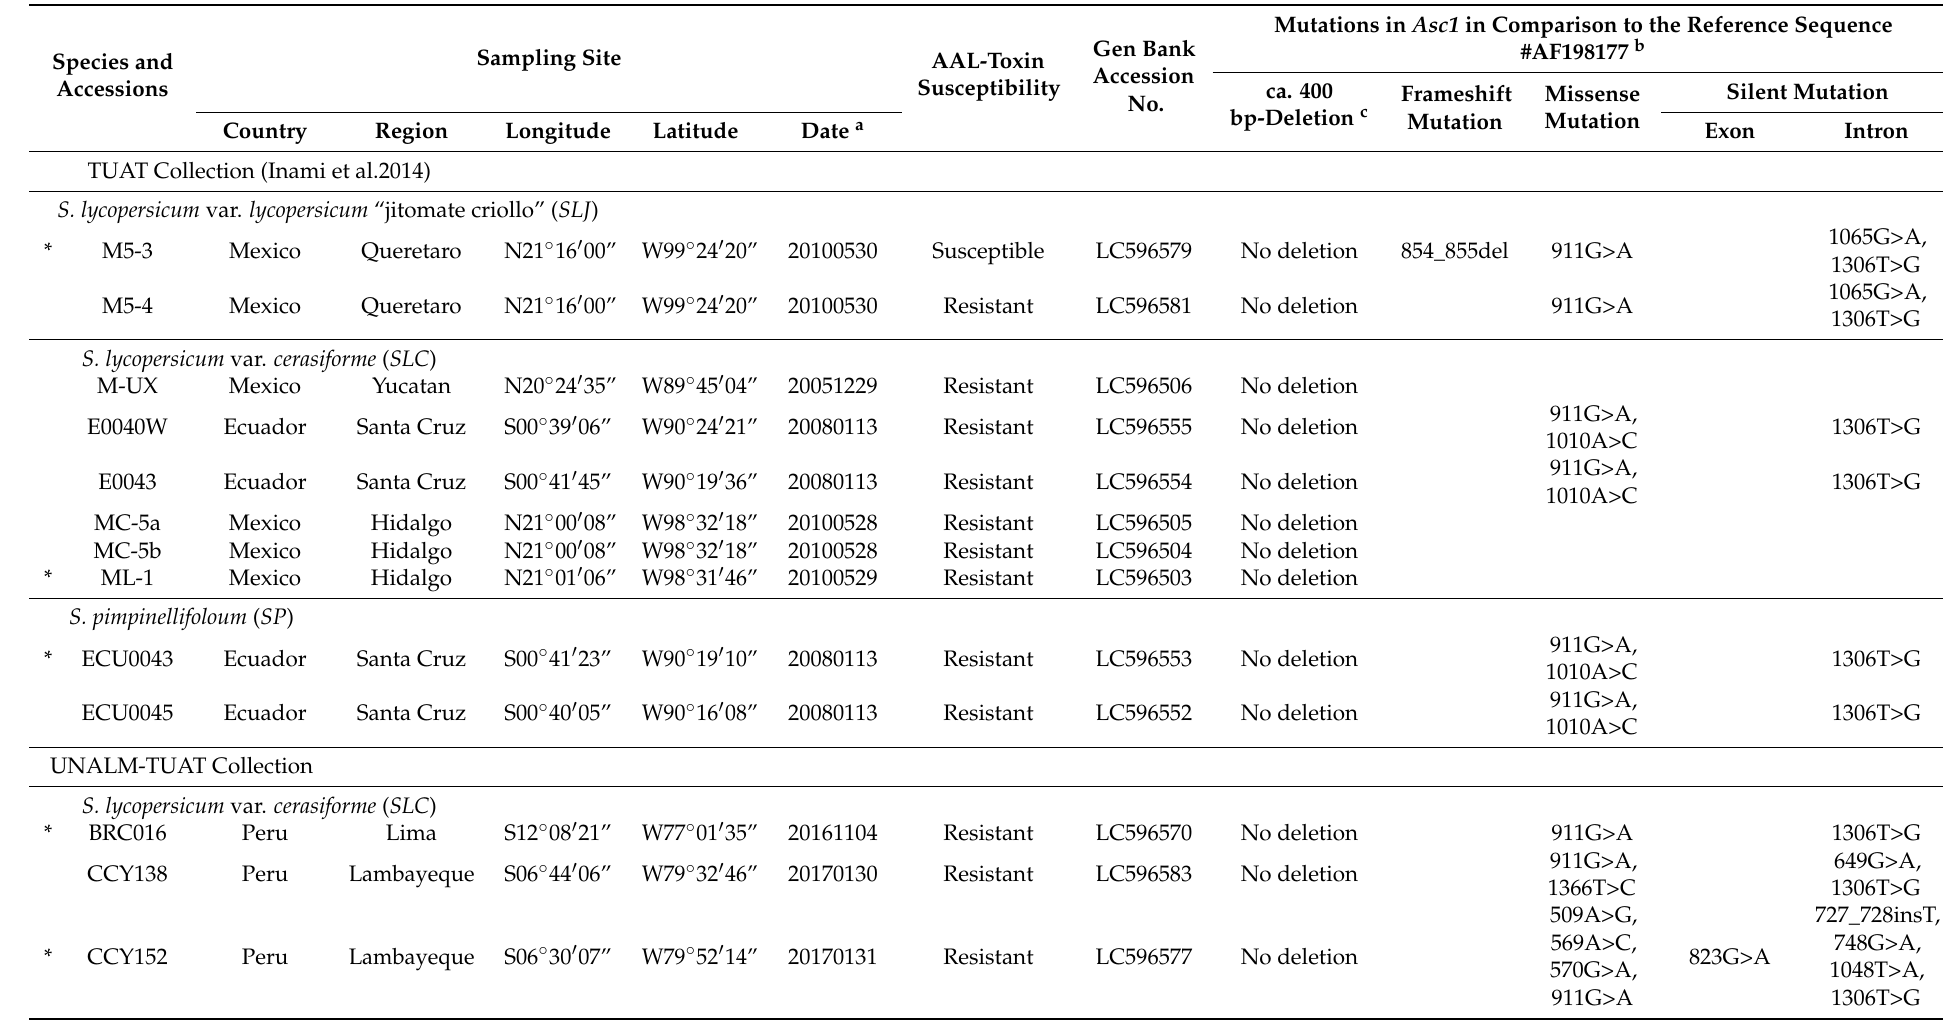
Table 1. Tomato accessions and cultivars used in this study, their susceptibility to AAL-toxin and mutations found in